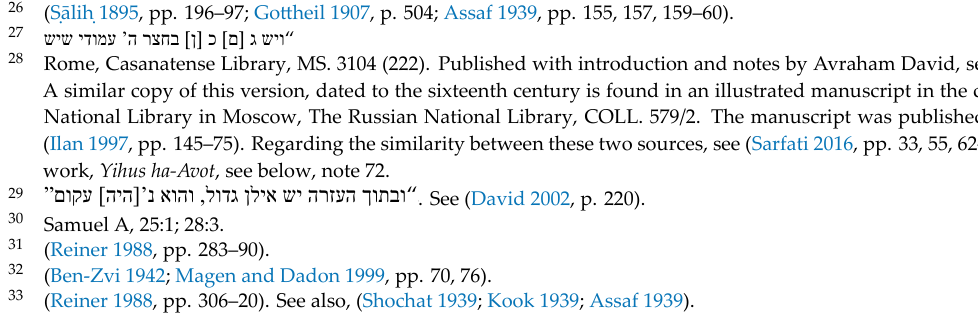
Figure 4. Florence, BNC, Ms. Magl. III, 43; Samuel’s tomb in Ramah (Nebi Samwil), early 14th century, by courtesy of Ministero dei beni e delle attività culturali e del turismo/Biblioteca Nazionale Centrale di